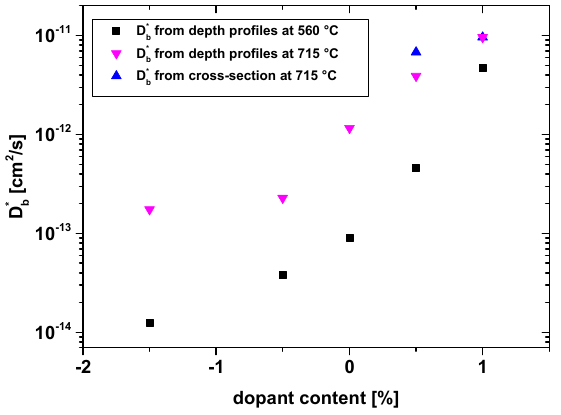
Figure 4. Bulk diffusion coefficients of the five analysed sample compositions. Negative dopant concentrations refer to donor dopant (La), positive to acceptor dopant (Fe).